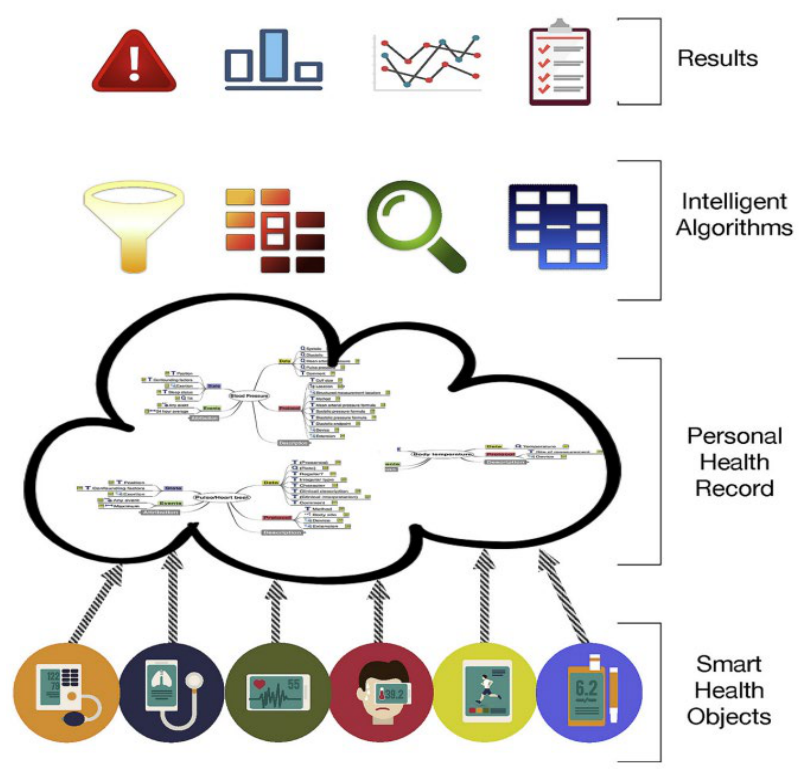
Figure 2. Overview of IoHT patient data layers [19].